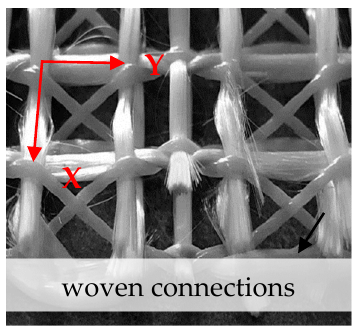
Figure 3. 3D, woven textile.